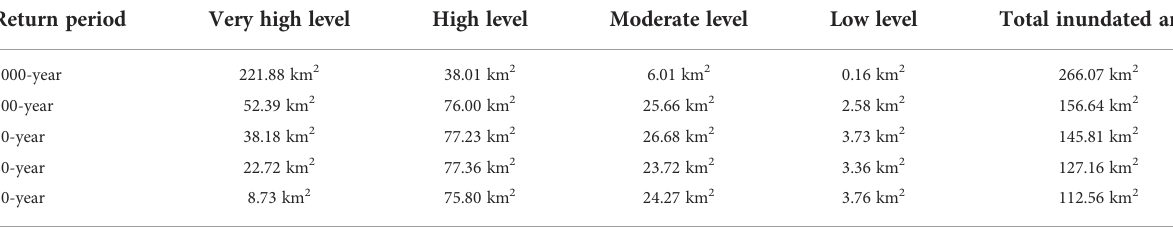
TABLE 3 Values of total inundated area and areas that are at hazard of storm surge inundation. Return period Very high level